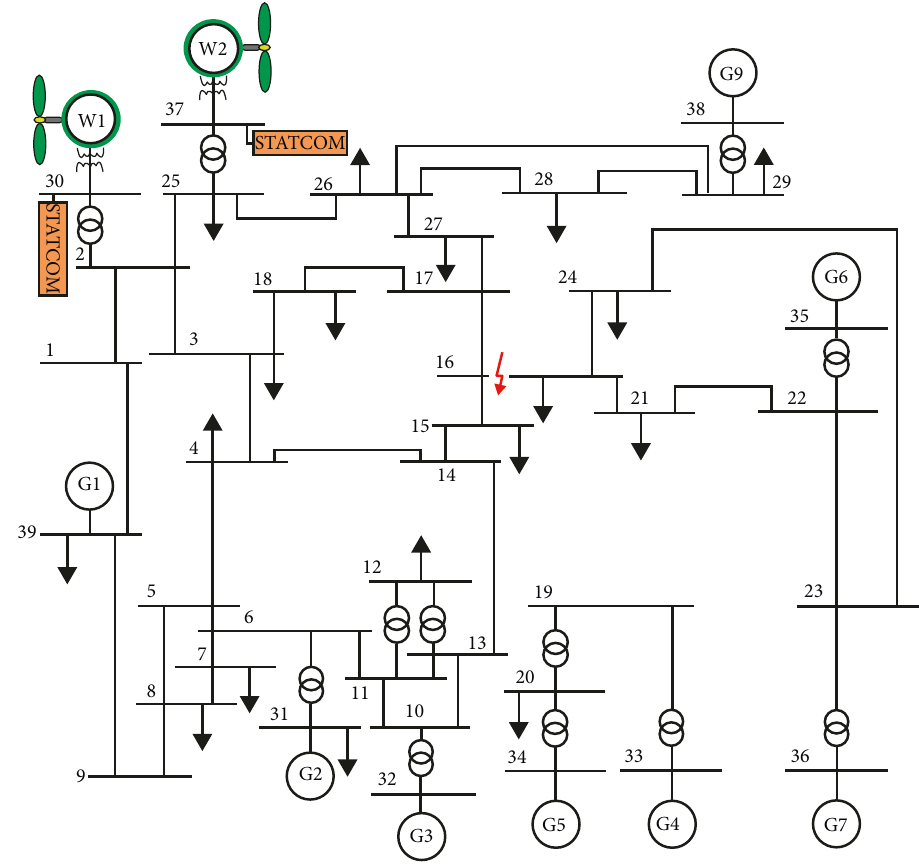
Figure 18: IEEE 39 bus test system From Figure 21, for WPP 1 at bus 30, some voltage fluctuations are observed. Voltage magnitude drops from 1 p.u. to 0.88 p.u. without STATCOM, whereas for the tuned models, the lowest voltage magnitude is 0.94 p.u. Voltage fluctuations are minimum at the WPP terminals during, and after fault clearance for WCA-PSO tuned STATCOM. The voltage profile at the terminals of WPP 2 at bus 37 is given in Figure 22. LLL-G fault are minimal, and the WPP rides through the grid fault. The WCA-PSO tuned STATCOM scenario has a better profile.